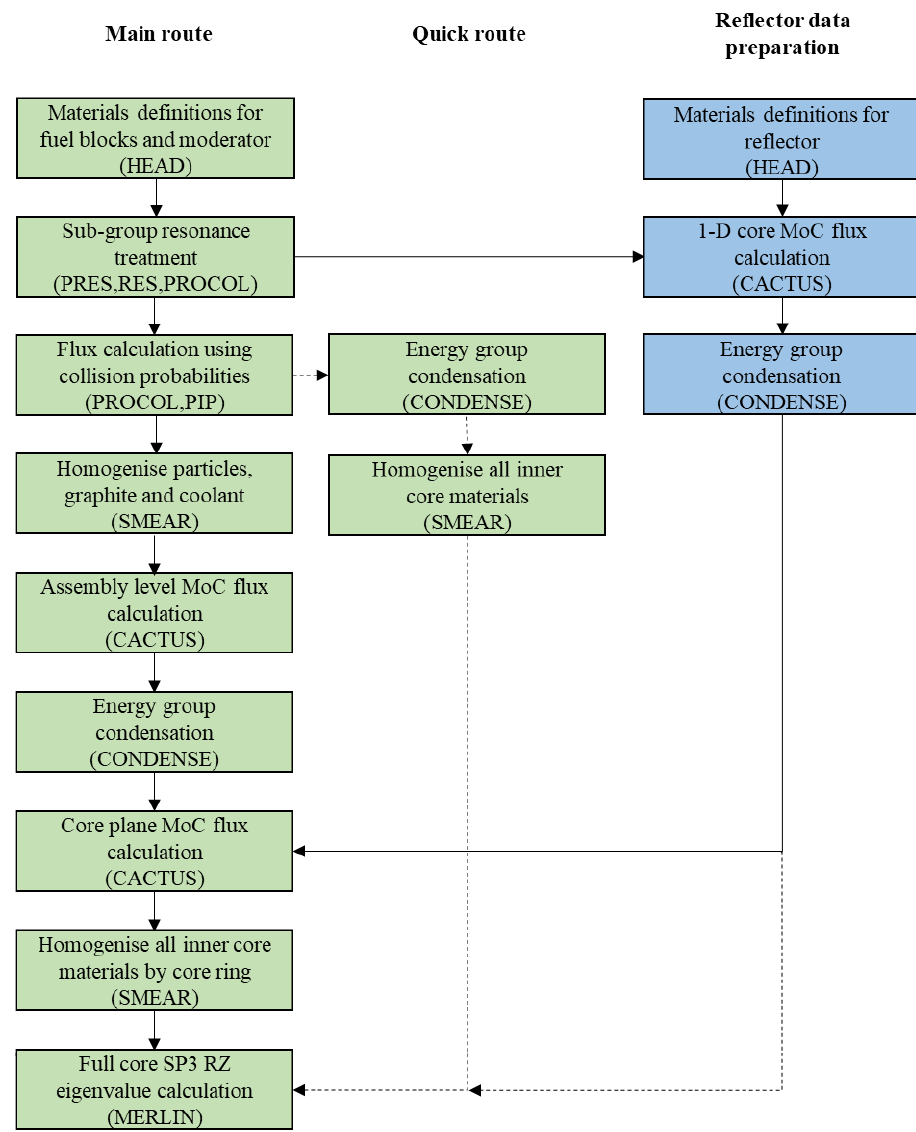
Figure 2: Flow chart for eigenvalue calculation showing two possible routes and a method for preparing reflector cross sections. Capitalised words are WIMS11